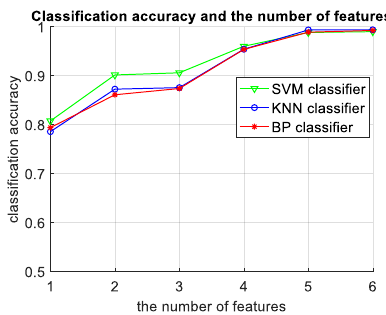
Figure 20. The relationship between classification accuracy and the number of features based on the measured data. Support vector machine (SVM), K-nearest neighbors (KNN), and back propagation (BP) neural networks.